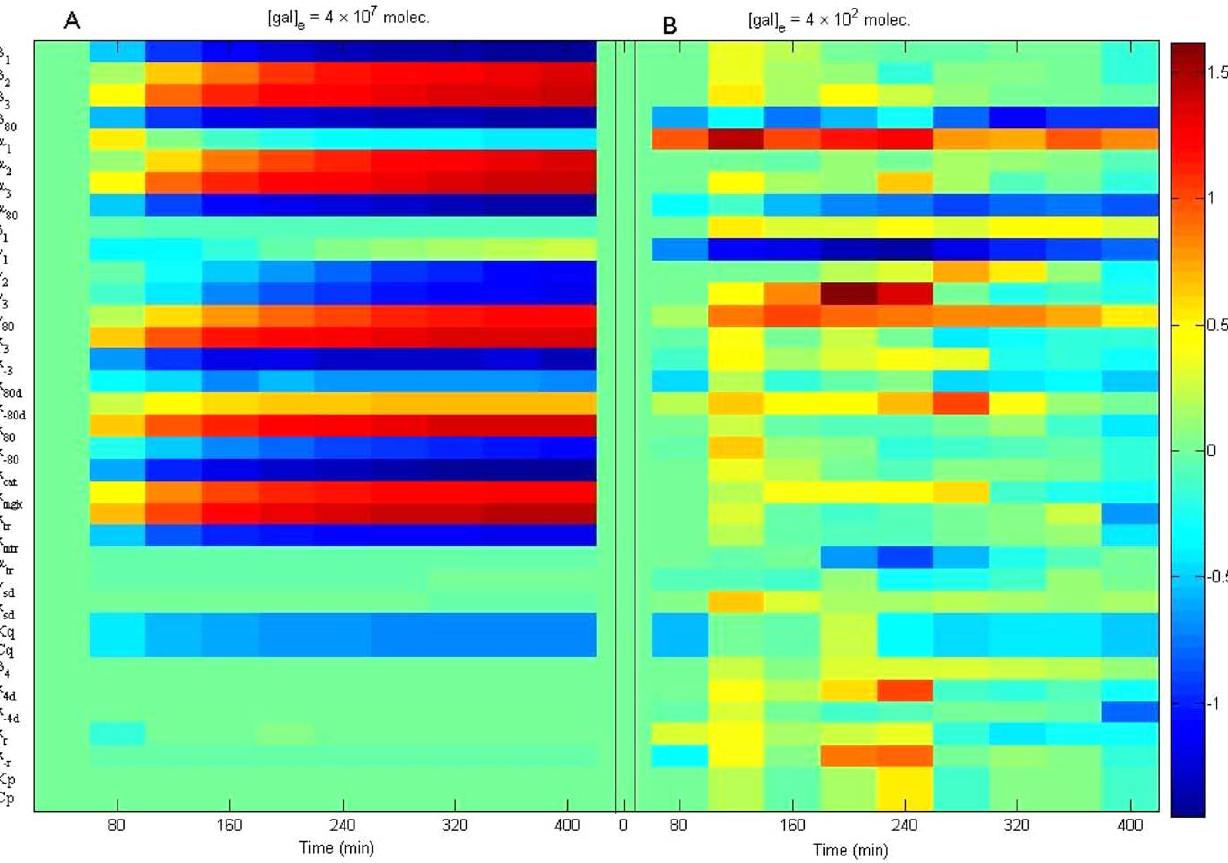
Figure 2. Normalized parameter sensitivity trajectory with respect to time. The heat map shows the normalized sensitivity of GAL 1 mRNA concentration ( m 1 ) towards change in all 35 parameters. Panel (A): Sensitivities when ½ gal (cid:3) ½ gal (cid:3) e ~ 4 | 10 2 molec : The sensitivities of the parameters d 1 , a tr , v sd , c 1 , b 4 , k 4 d , k { 4 d , k { r , k r , K p , C p and k sd are much smaller than those of the other parameters (approximately zero, green color). In general, when the external galactose ½ gal (cid:3) and c 1 .